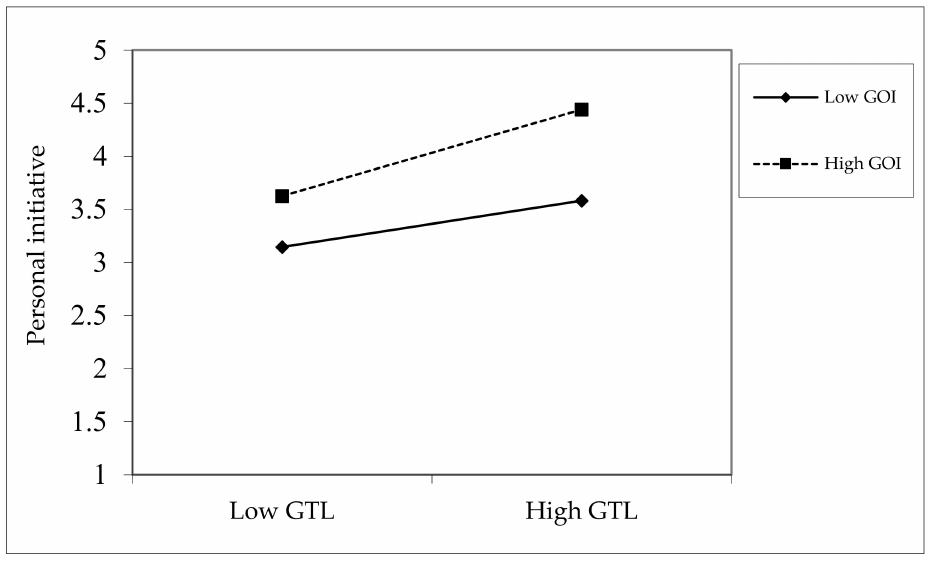
Figure 2. The moderating effect of GOI on GTL and